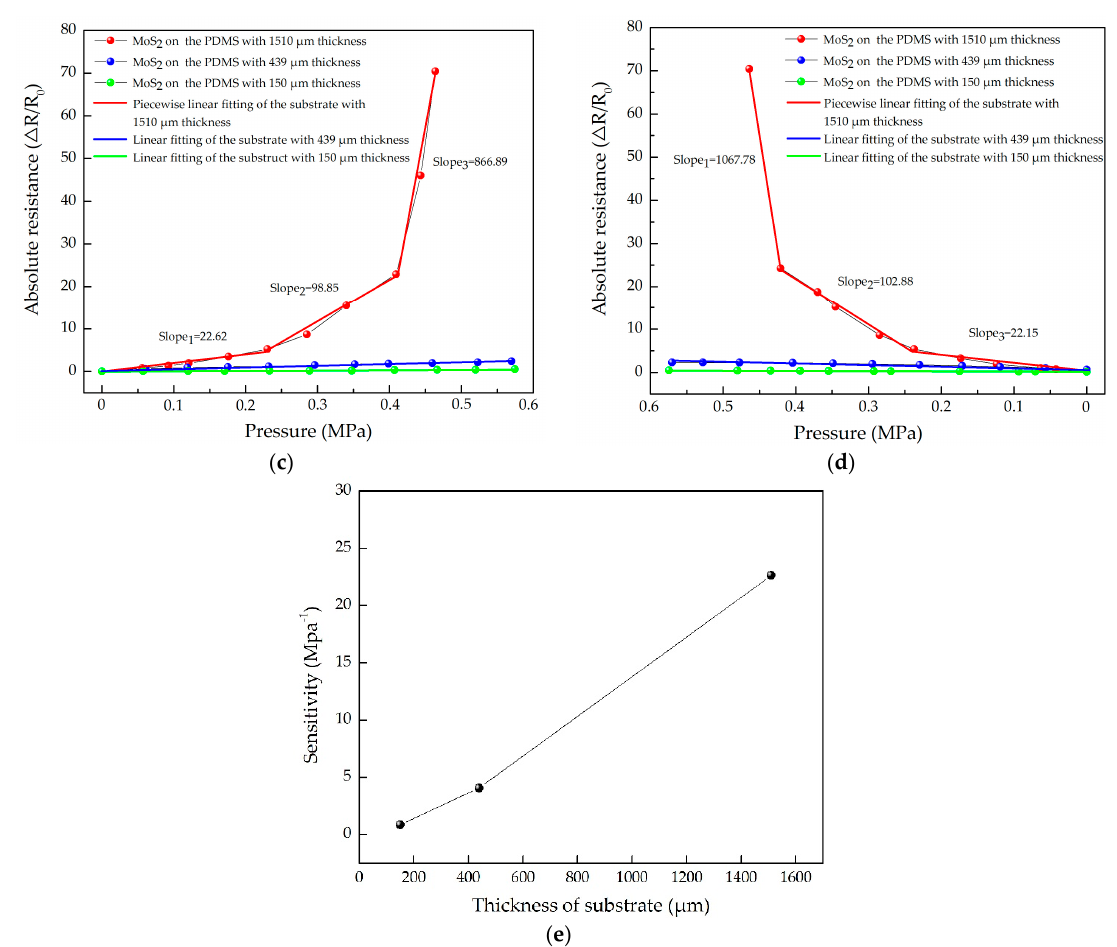
Figure 10. The piezoresistive property test of sputtered MoS 2 film: ( a ) the piezoresistive testing system for thin films; ( b ) the schematic diagram of the film surface compression: ( i ) the state of Scheme 2 before pressure; ( ii ) the state of sputtered MoS 2 under pressure; ( c , d ) pressure test curves of MoS 2 films deposited on PDMS substrates with different thicknesses at the power of 350 W; ( e ) the relationship diagram between the thickness of the substrate and the sensitivity of MoS 2 sputtered on the substrate at 0–0.23 MPa.